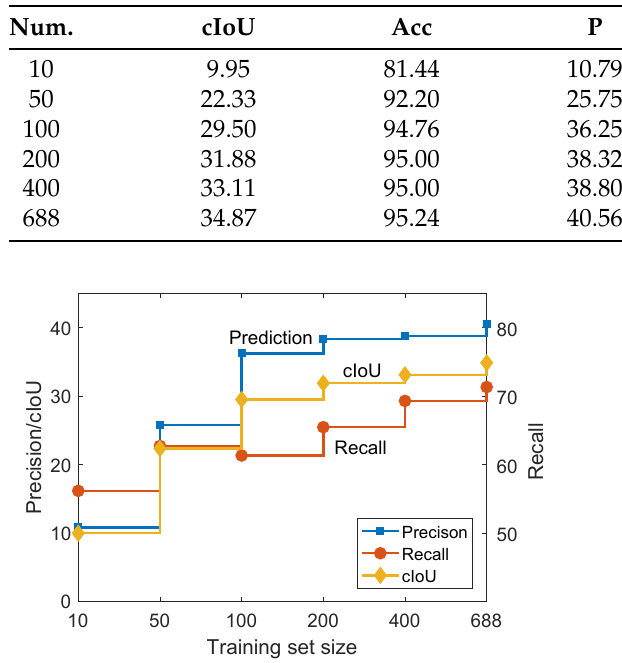
Figure 5. The performance of the network vs. the training set